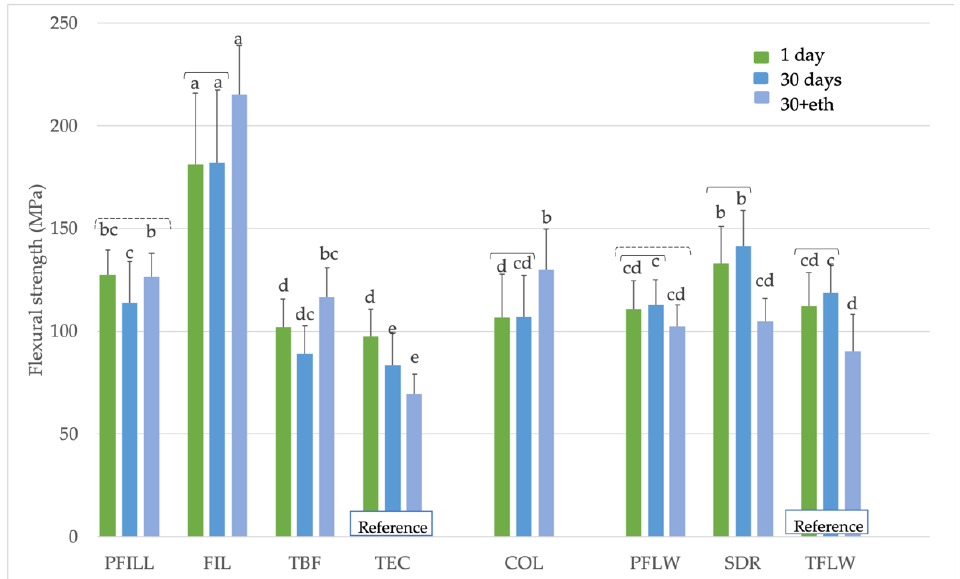
Figure 2. Flexural strength (MPa) of tested materials. Equal letters represent statistically homogeneous groups for a particular time point. Parentheses indicate statistically similar groups for a particular material. Dashed parentheses indicate statistically homogeneous groups within the same material, which are not similar to the column in between (in cases where the time dependence is not monotonous), p < 0.05.